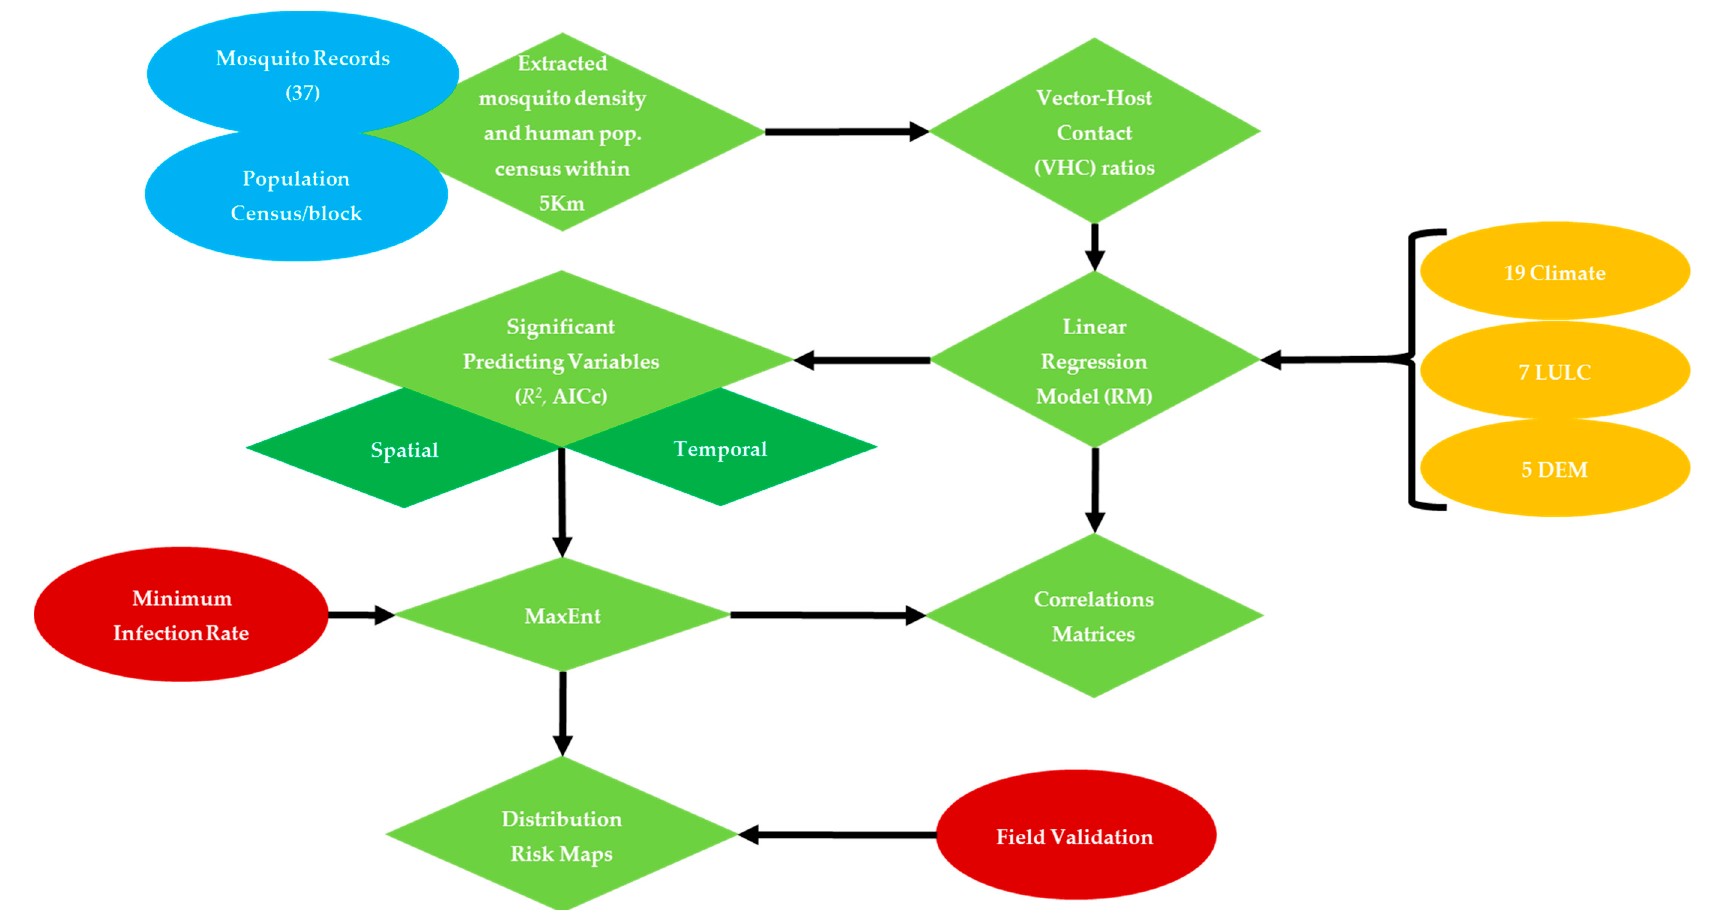
Figure 2. West Nile Virus transmission model, and expected outcomes in response to proposed predicting variables.